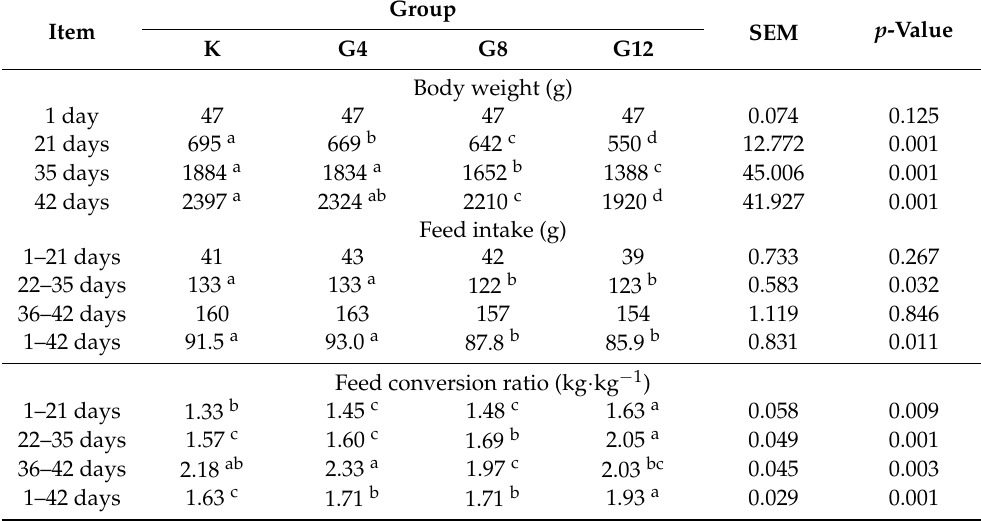
Table 5. The rearing performance of broiler chickens fed graded levels of guar